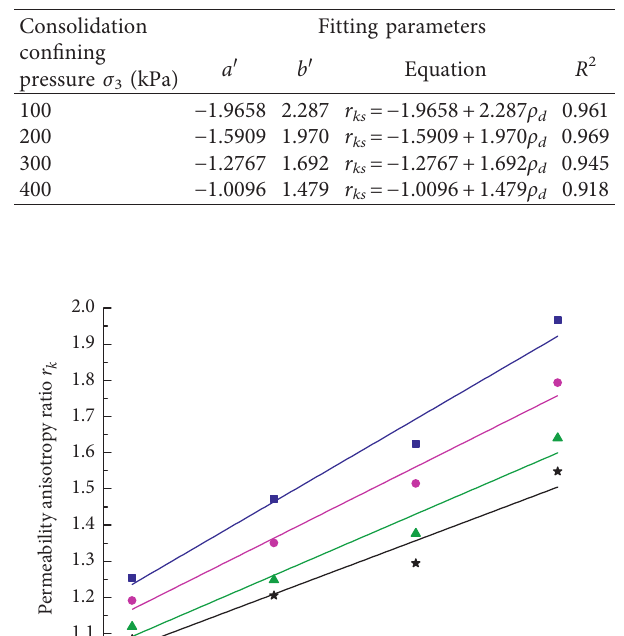
0 consolidation.